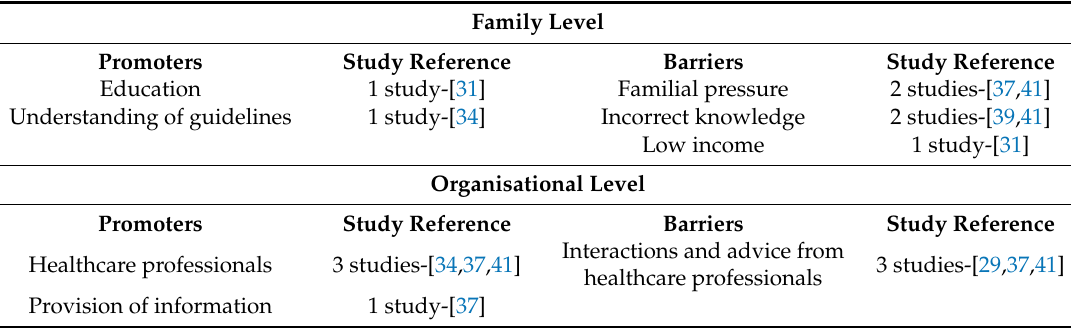
Table 4. Factors influencing CF